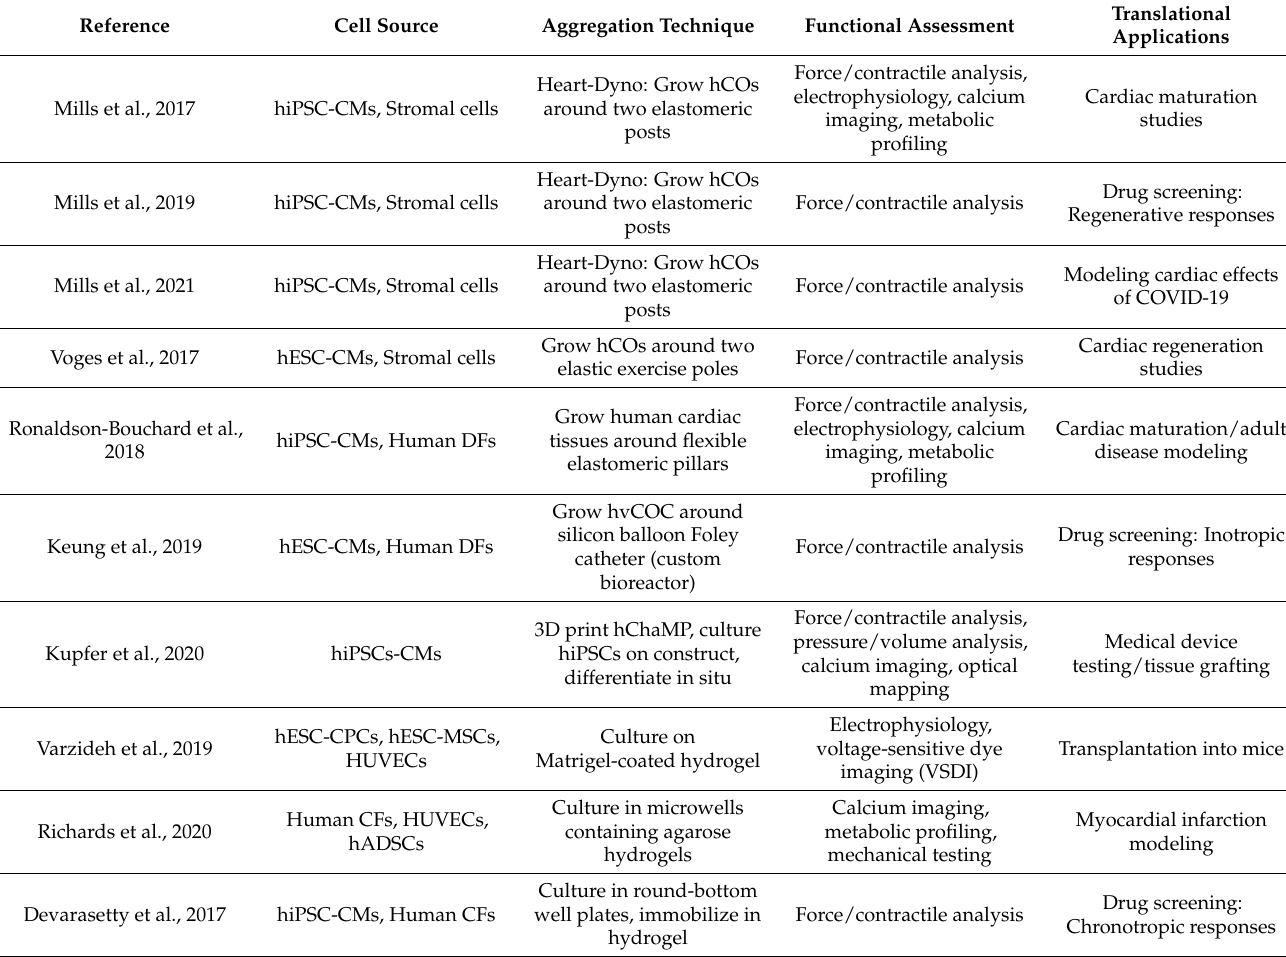
Table 1. Cardiac Organoids by Direct Assembly: techniques, characteristics, and